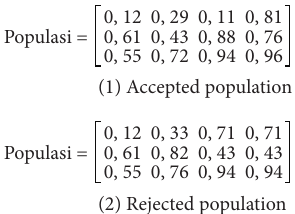
Figure 3: Initialization of the search agent position.